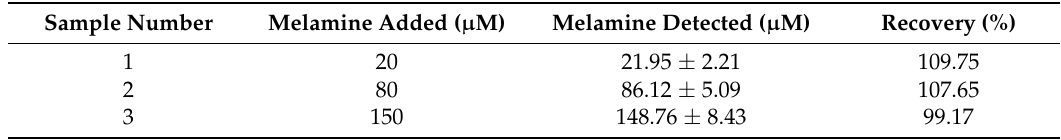
Table 1. Determination of melamine in milk samples using the proposed method.